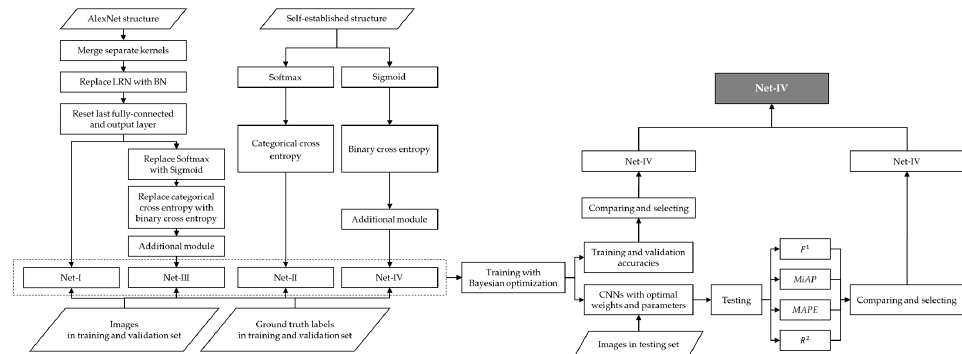
Figure 8. Flow chart of research methodology and results evaluation.